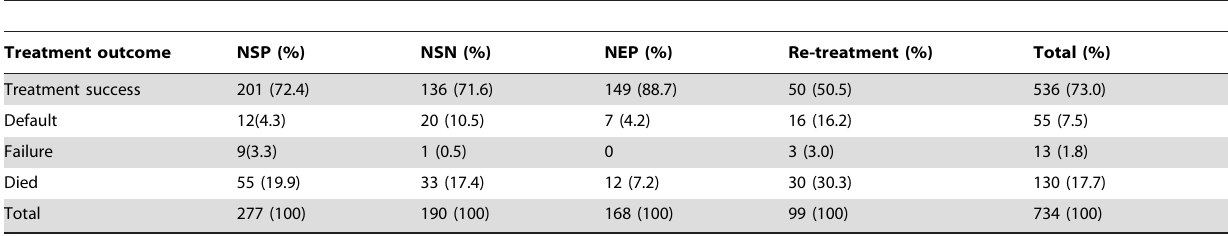
Table 3. Tuberculosis treatment outcomes among HIV-infected TB patients, Andhra Pradesh 2007 (N =734).